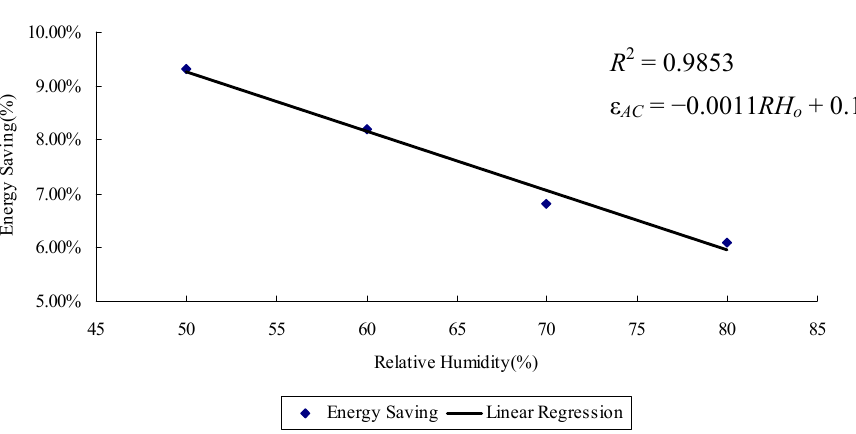
Figure 16. Energy saving potential of various Airflow